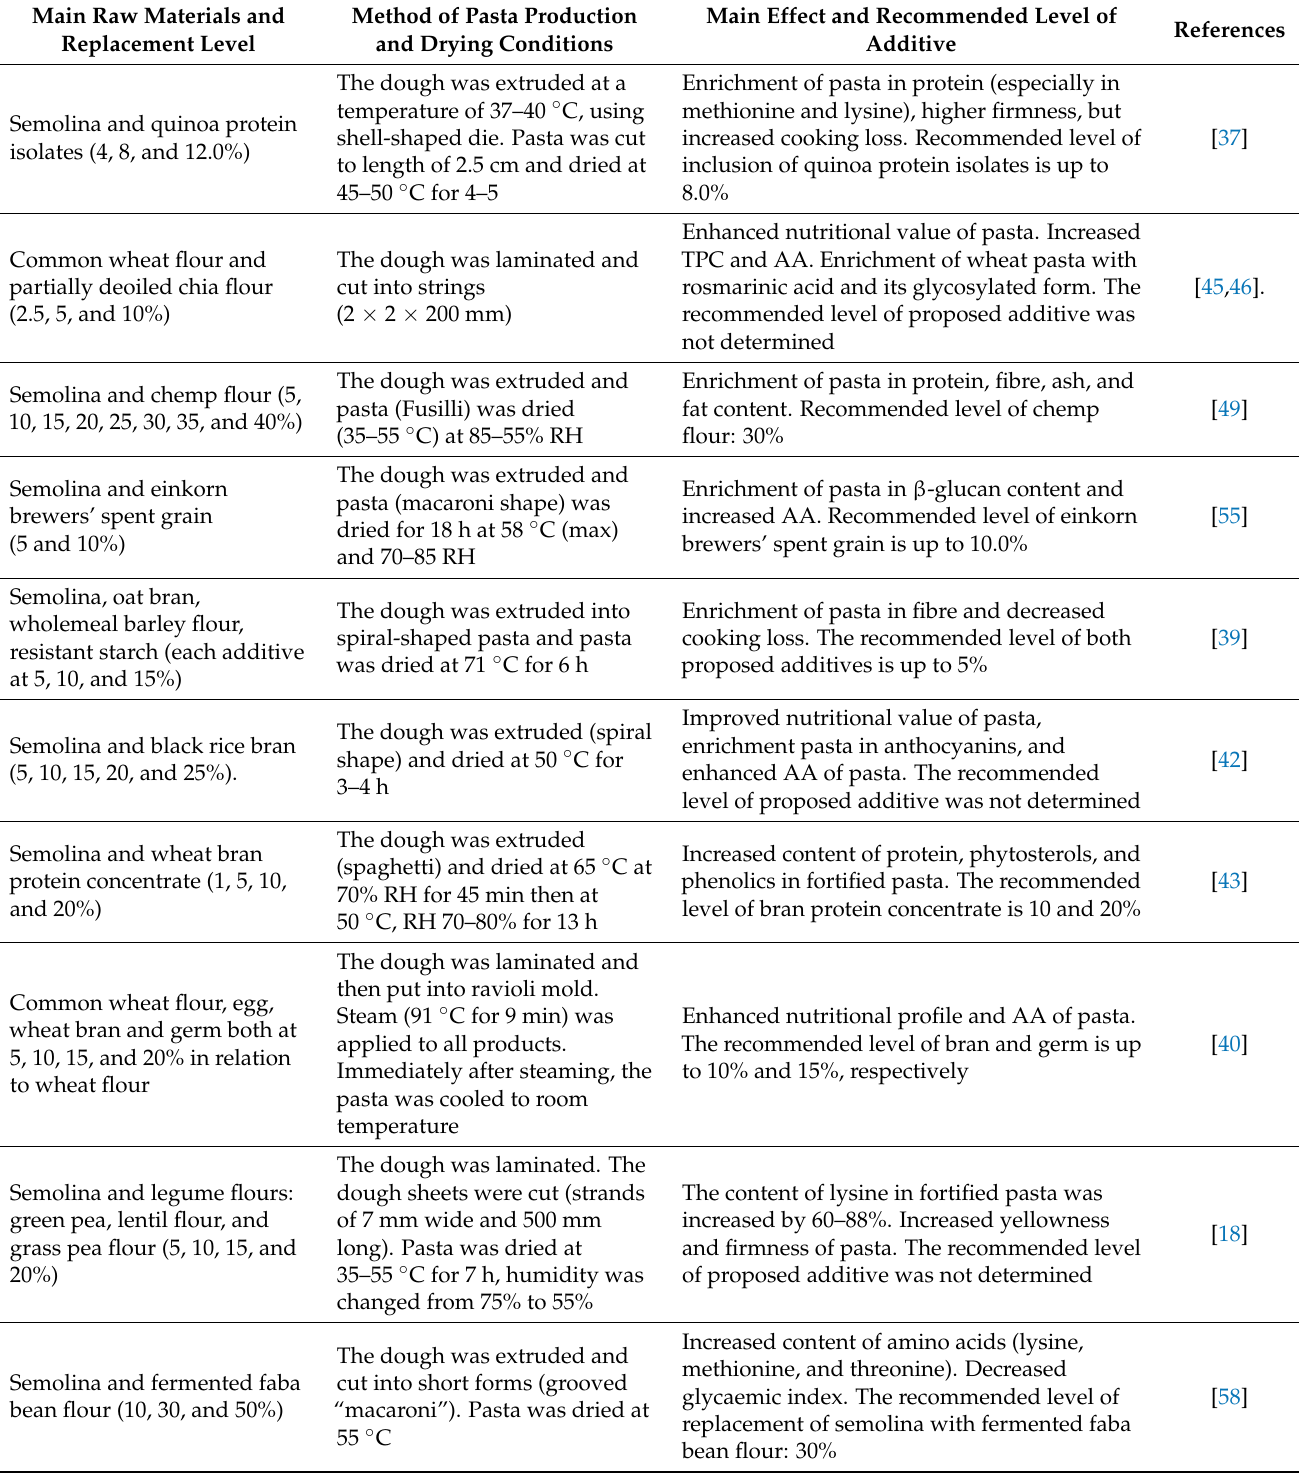
Table 2. Effect of cereal grain and seed addition on nutritional value of wheat